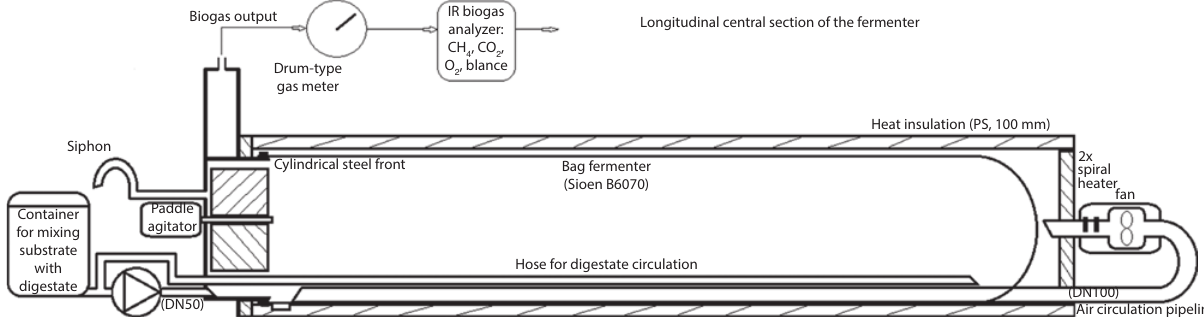
Figure 1: Model bioreactor schema – longitudinal